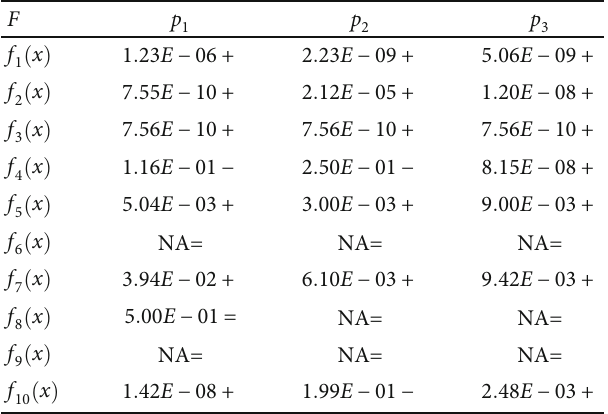
Table 9: Rank sum test value under classical test